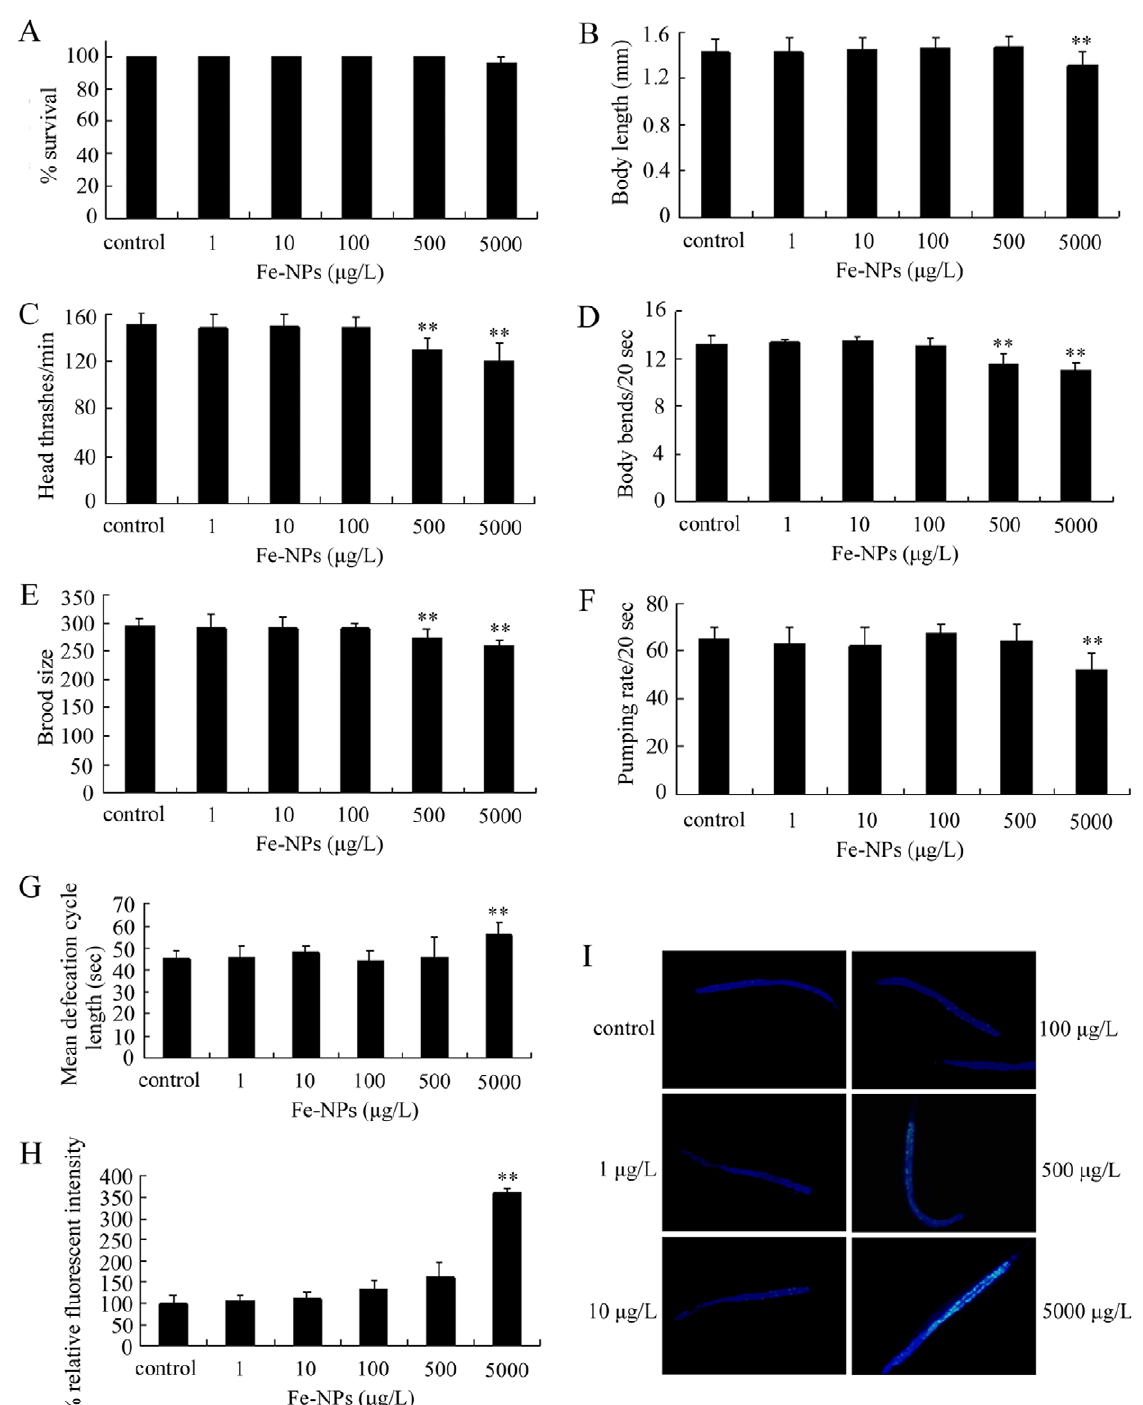
Figure 2. Toxicity evaluation in nematodes exposed to DMSA coated Fe 2 O 3 -nanoparticles from L1-larvae to adult. (A) Comparison of lethality in nematodes exposed to different concentrations of Fe 2 O 3 -nanoparticles. (B) Comparison of body length in nematodes exposed to different concentrations of Fe 2 O 3 -nanoparticles. (C) Comparison of head thrash in nematodes exposed to different concentrations of Fe 2 O 3 -nanoparticles. (D) Comparison of body bend in nematodes exposed to different concentrations of Fe 2 O 3 -nanoparticles. (E) Comparison of brood size in nematodes exposed to different concentrations of Fe 2 O 3 -nanoparticles. (F) Comparison of pumping rate in nematodes exposed to different concentrations of Fe 2 O 3 -nanoparticles. (G) Comparison of mean defecation cycle length in nematodes exposed to different concentrations of Fe 2 O 3 -nanoparticles. (H) Comparison of intestinal autofluorescence in nematodes exposed to different concentrations of Fe 2 O 3 -nanoparticles. (I) Pictures showing the intestinal autofluorescence in nematodes exposed to different concentrations of Fe 2 O 3 -nanoparticles. Bars represent mean 6 S.E.M. * p , 0.05, ** p , 0.01.